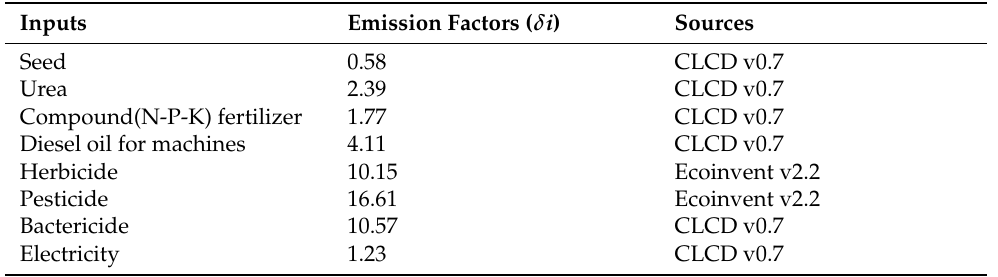
Table 2. Agricultural inputs in wheat production and CO 2 emission factors ( δ i in kg CO 2 -eq · kg − 1 or kg CO 2 -eq · kWh − 1